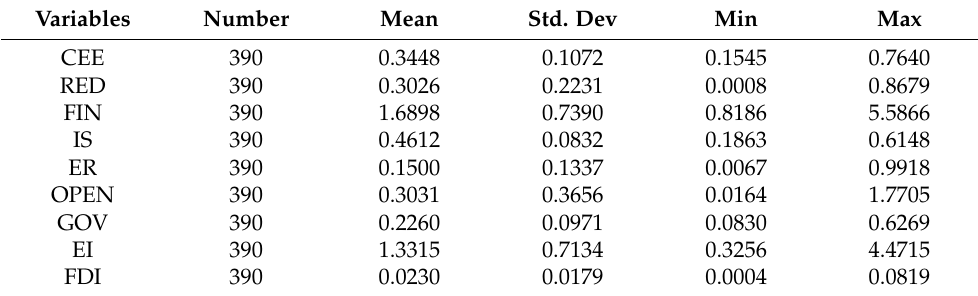
Table 3. Descriptive statistics of